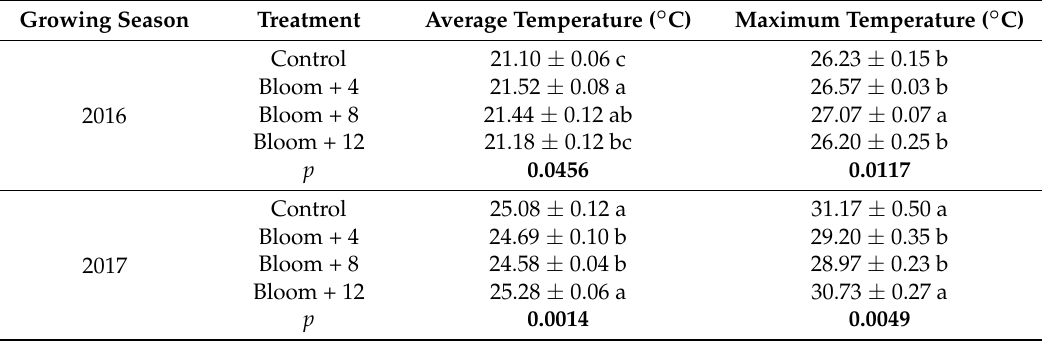
Table A3. Fermentation Temperature by treatment and growing season. Treatment means followed by standard error of the mean. Different letters within a column and growing season indicate significant differences between treatment groups for Fisher’s LSD at p < 0.05. p values below 0.05 are shown in bold